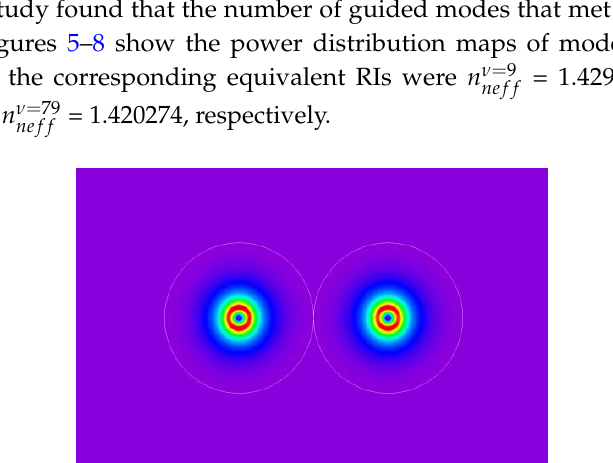
Figure 5. 2D power distribution plot for guided-mode ν = 9 ( 𝑛 𝑛𝑒𝑓𝑓𝜈=9 = 1.429881).